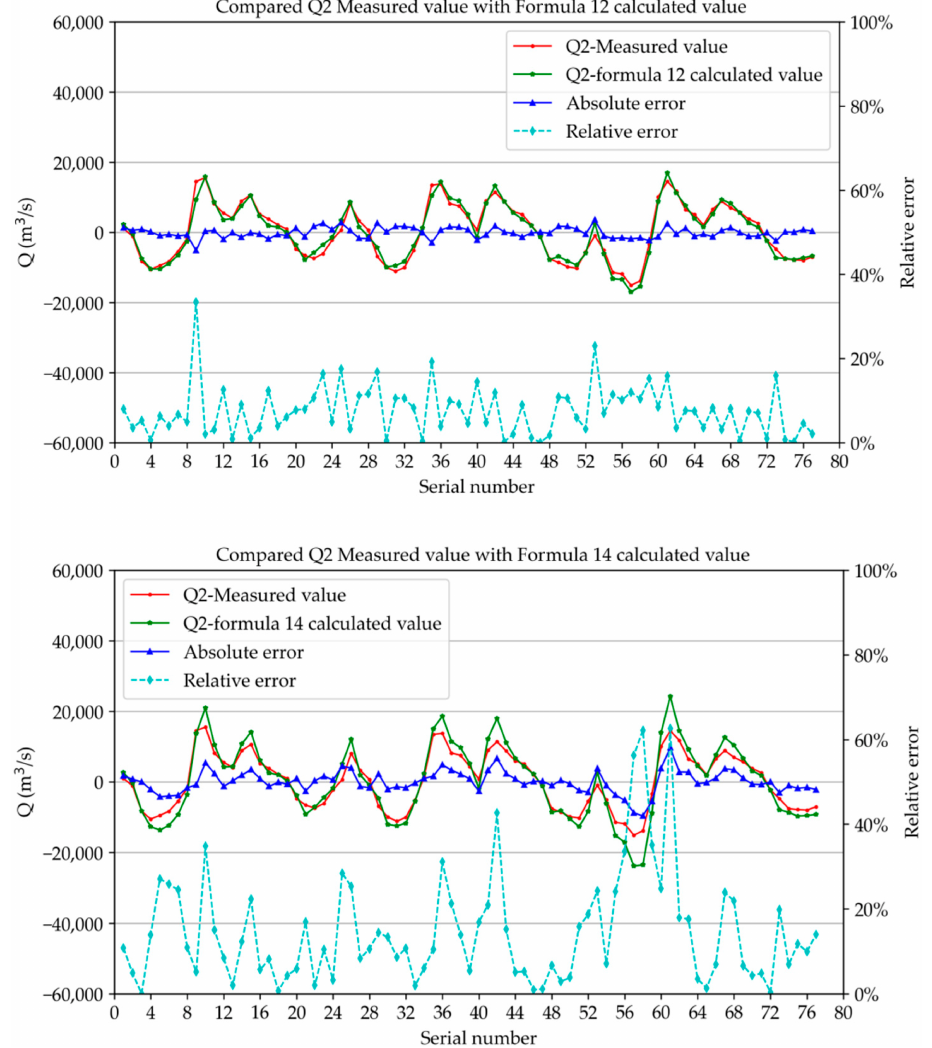
Figure 14. Comparison between Q 2 measured value and calculated value of